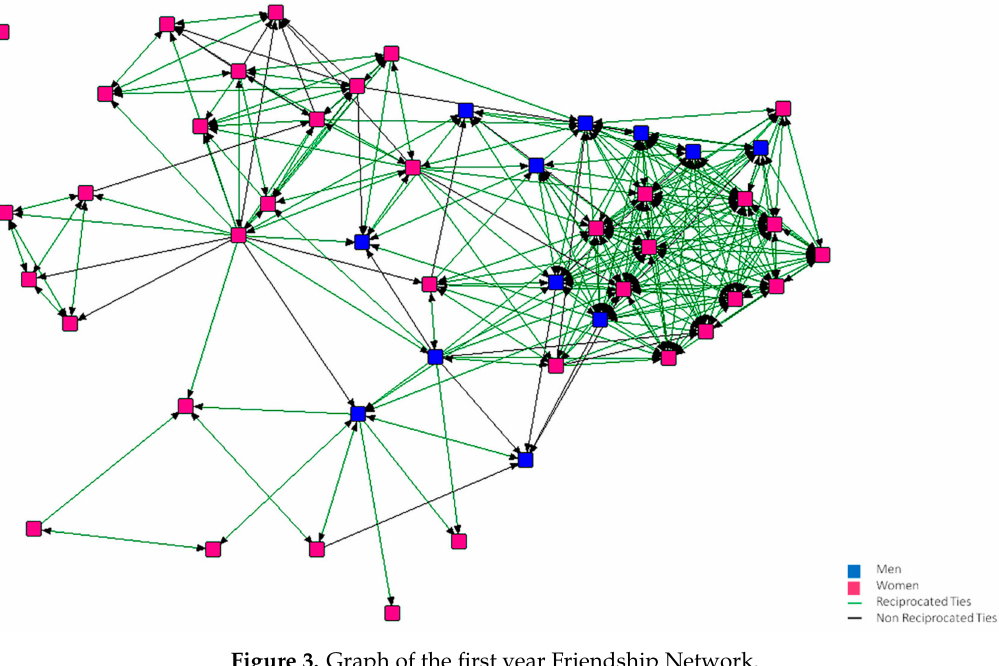
Figure 3. Graph of the first year Friendship Network.